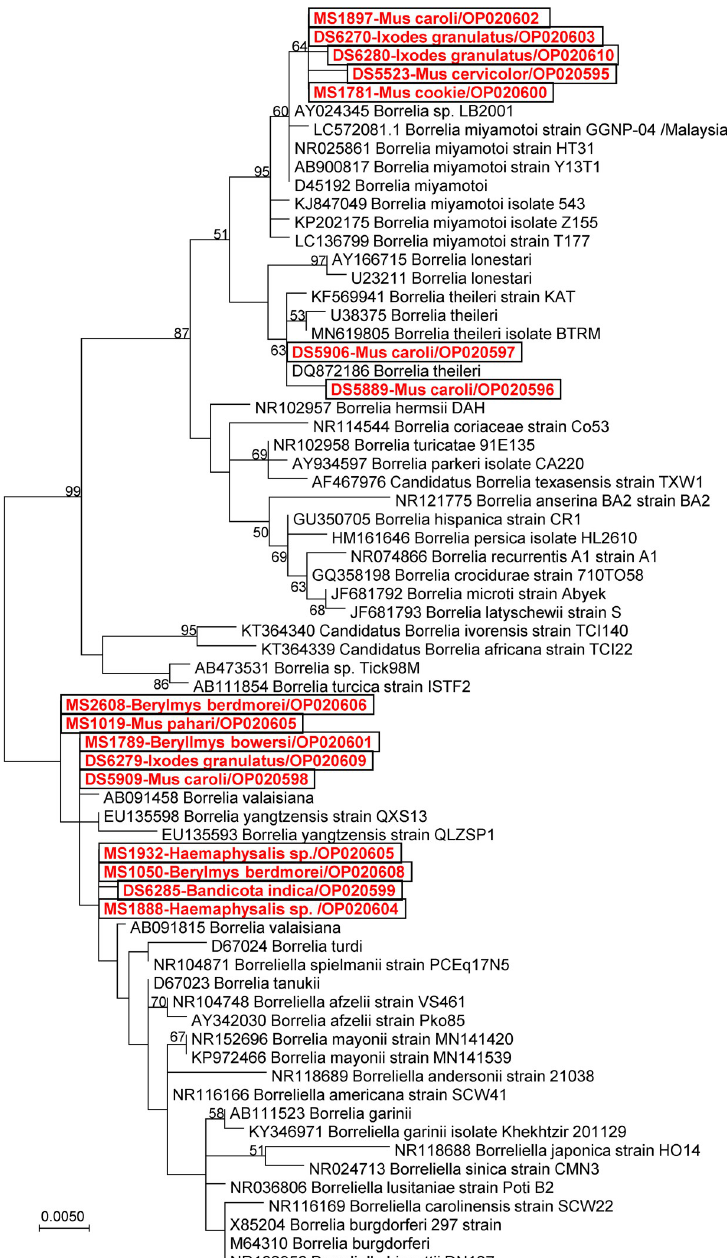
Fig 3. Phylogenetic trees of flagellin gene of Borrelia species detected in rodents and their associated ticks in Phop Phra district, Tak province, Thailand (2019–2020). Rodent exposure rate to B . miyamotoi and evidence of serological reactivity in humans The serological reactivity to B . miyamoto i rGlpQ protein was determined in patient and rodent sera using the in-house ELISA assays detecting human IgG and rodent IgG against B . miyamo- toi rGlpQ protein (38 kDa). The rGlpQ protein quality was checked by running the